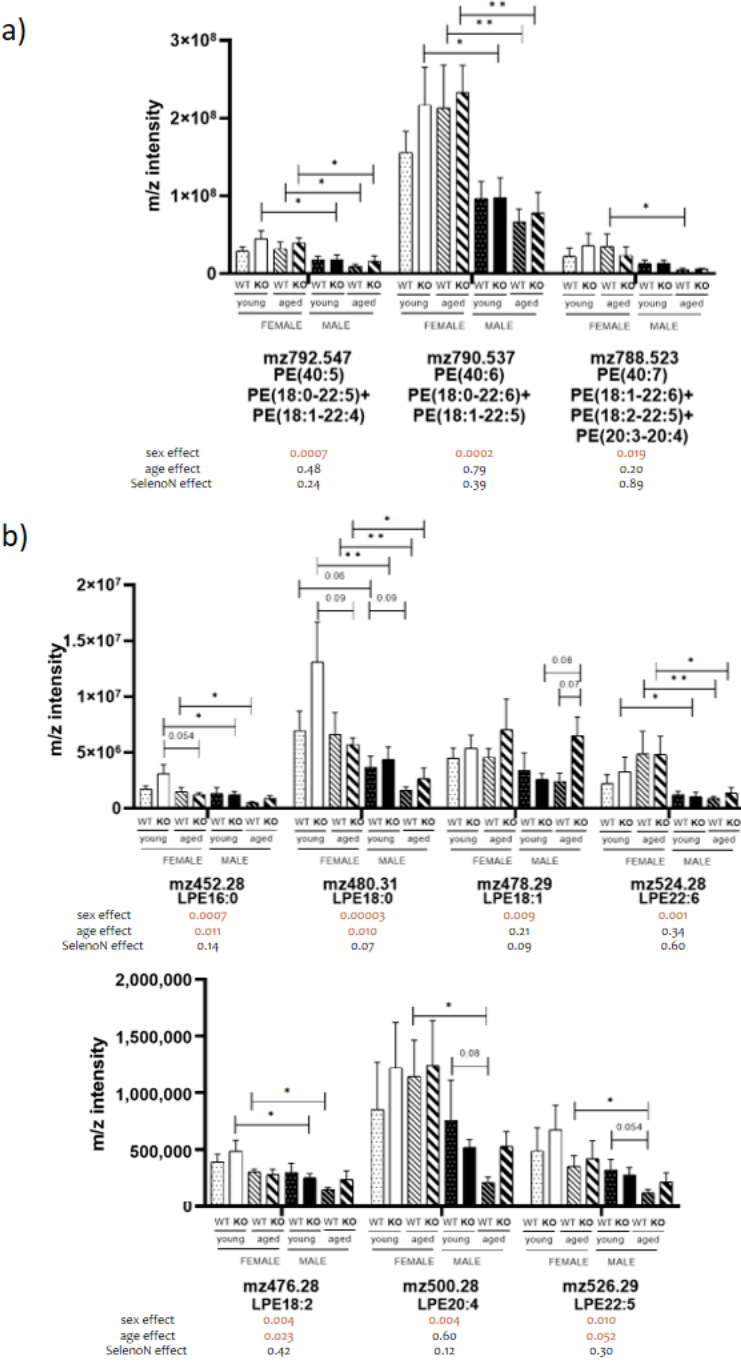
Figure 3. Ethanolamine-containing PLs in diaphragm. ( a ) Analysis of m / z intensity of PE species (mean ± SEM; n = 4 for each group, except young male WT and KO with n = 5 and aged male KO with n = 3). ( b ) Analysis of m / z intensity of LPE species. In the graph, p -value are from Tukey’s post hoc tests between pairwise groups. Under the graph, p -values for sex, age and SelenoN effect are defined in Table 2. * p < 0.05 and ** p < 0.01.